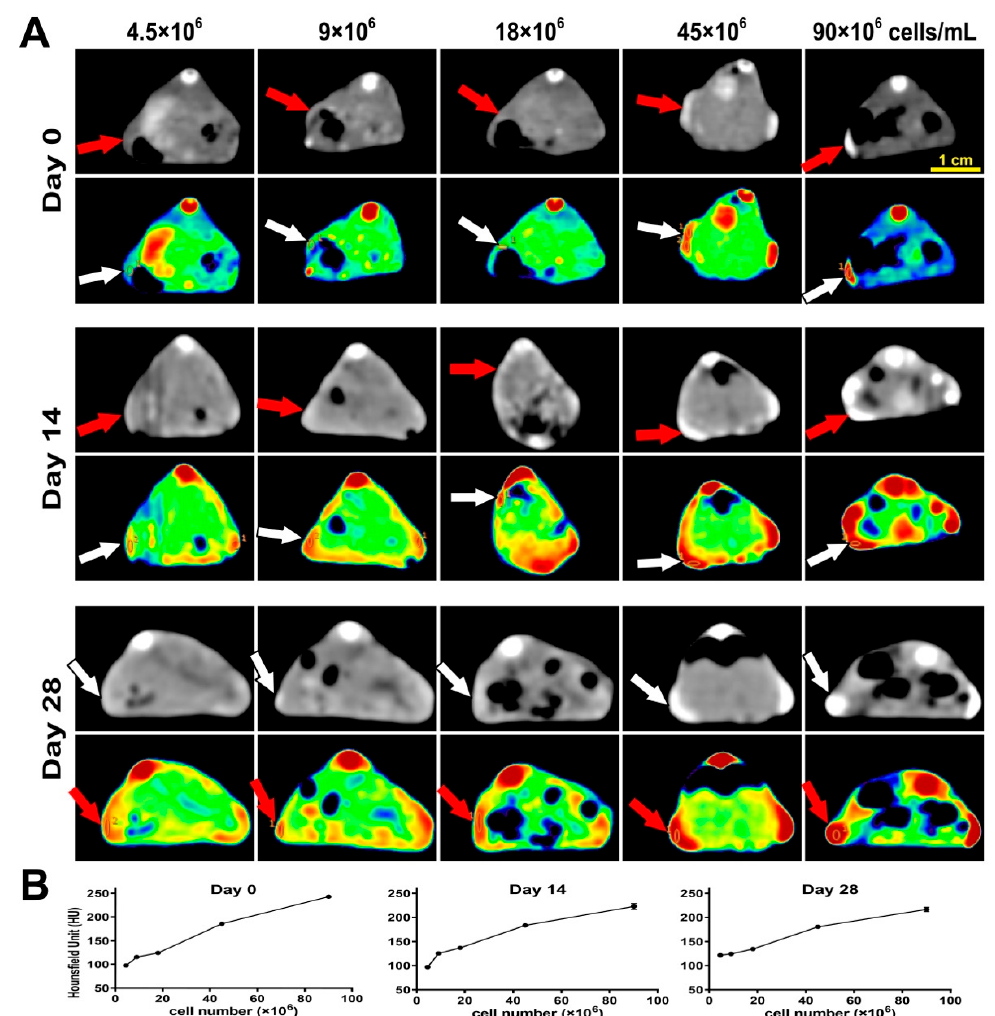
Figure 7. In vivo CT imaging of hydrogel constructs containing UCNP@SiO 2 -TS-labeled CSPCs of increasing numbers (4.5–90 × 10 6 cells/mL). ( A ) In vivo transverse CT images of the implanted constructs (indicated by red arrows in greyscale and white arrows in pseudo-color) on days 0, 14, and 28 post-implantation. ( B) Corresponding CT values of the regions of interest (denoted by yellow circles in A).